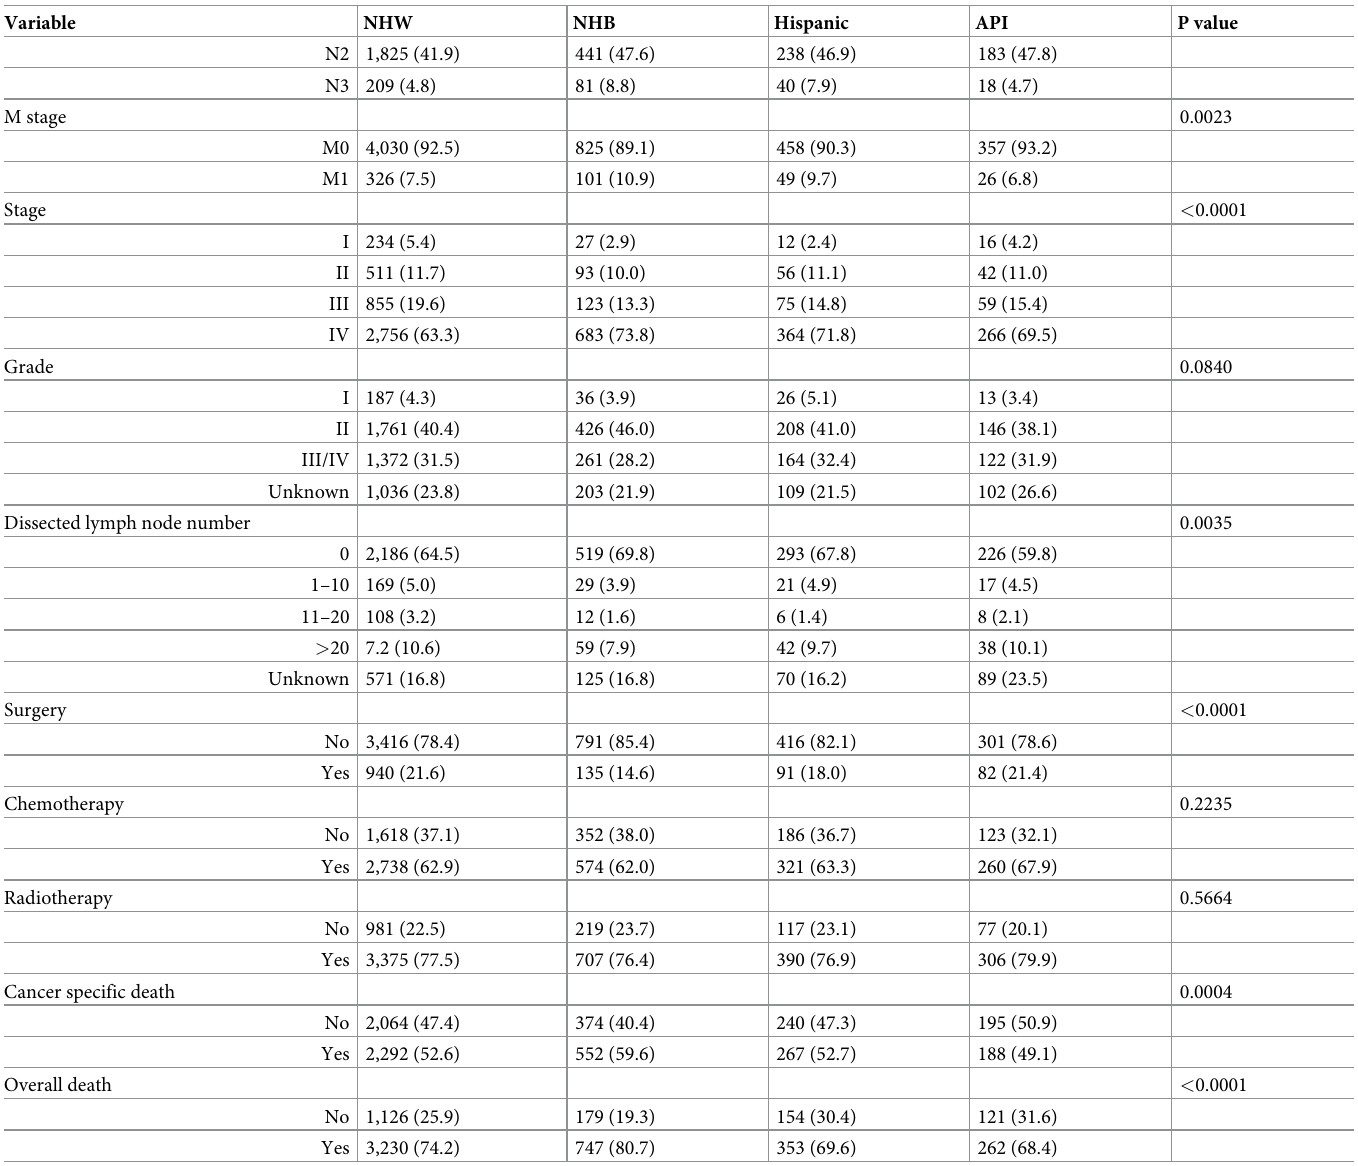
Racial disparity in cancer specific and overall survival in all patients with HPSCC Survival curves for all HPSCC patients showed that NHB had significantly worst cancer spe- cific and overall survivals among all races (S1A and S1B Fig). Multivariate survival analysis indicated that NHB patients had a significantly increased risk of overall death (HR = 1.11, 95% CI: 1.02–1.21, P = 0.0117), but not cancer specific death (HR = 1.07, 95% CI: 0.97–1.18, P = 0.1664). Hispanic patients were associated with better cancer specific